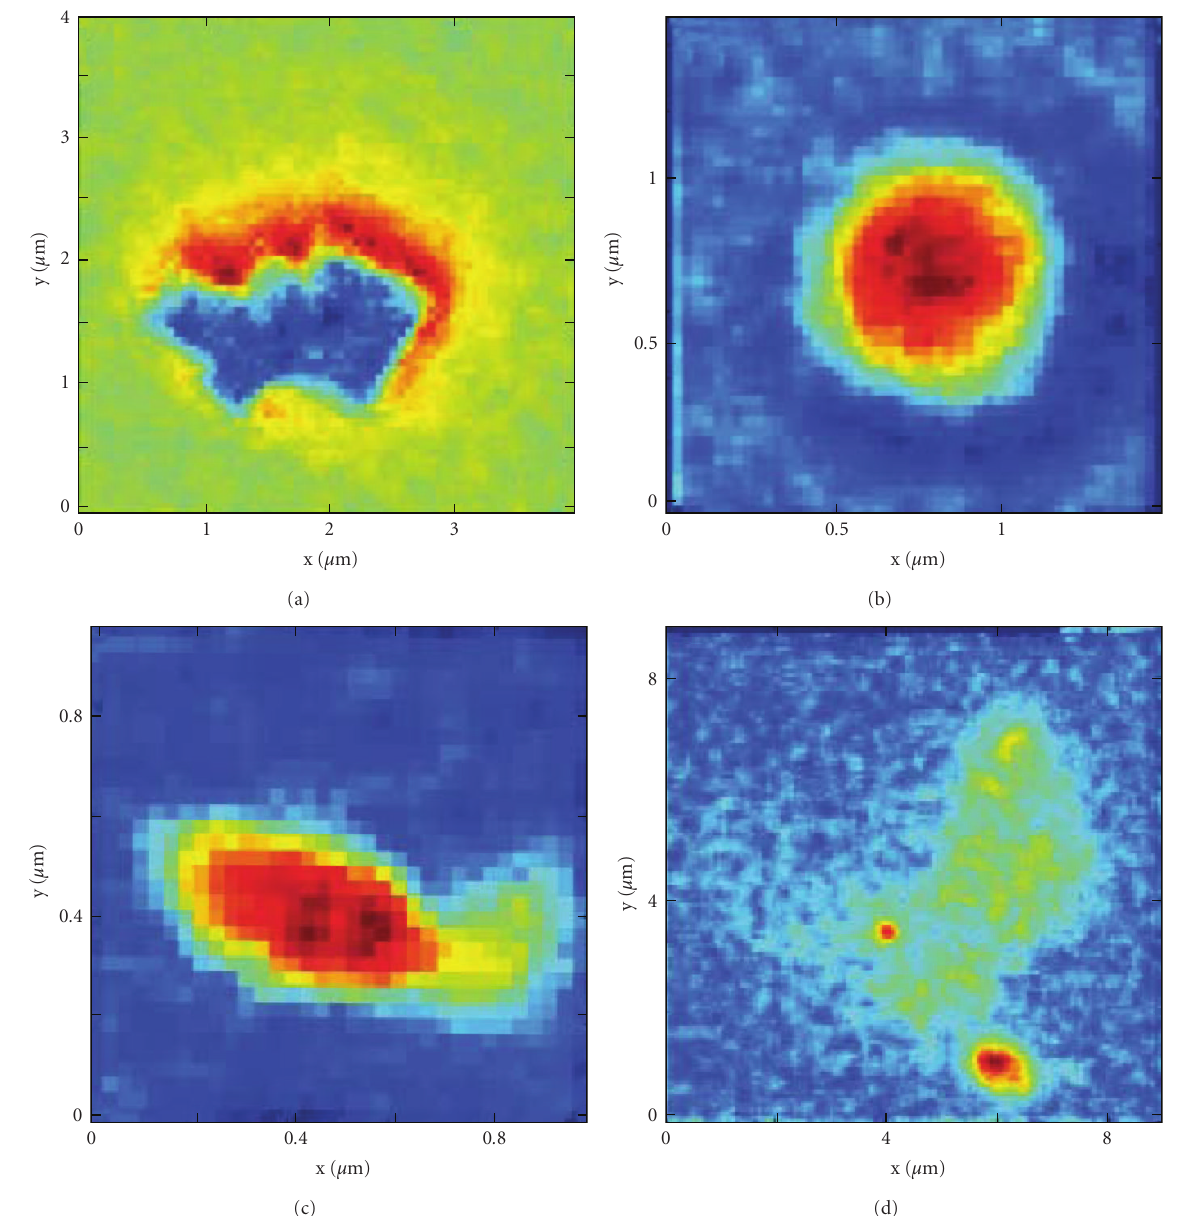
Figure 4: Relative carbon images of representative particles for (a) PsI, (b) PsII, (c) calcareous phytoplankton, and (d) proteinaceous particle types. For each image, the red-blue color scale is relative to individual particle carbon absorption, where red denotes the maximum carbon absorption and blue denotes the